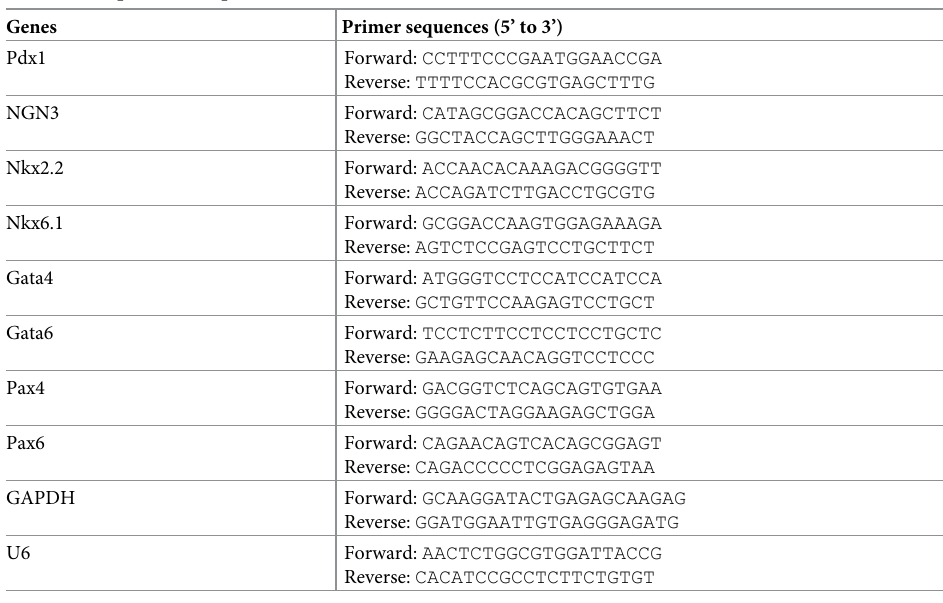
Table 1. The primers for